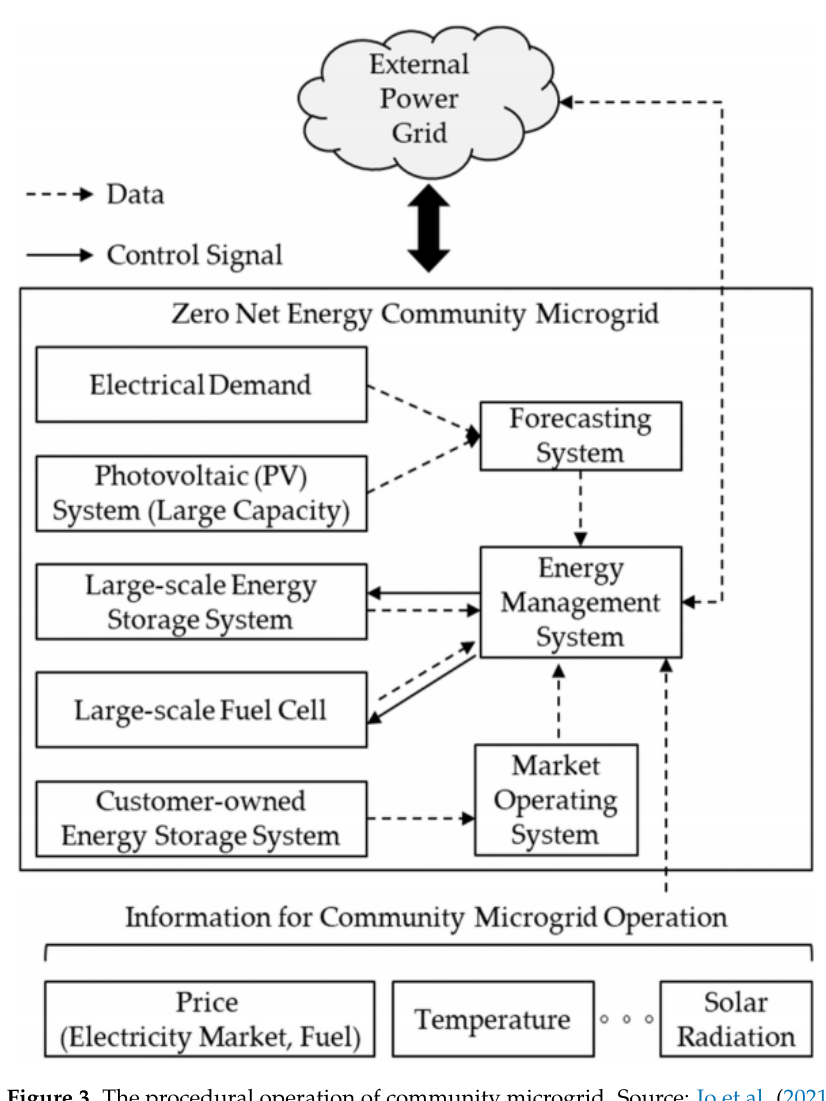
Figure 3. The procedural operation of community microgrid. Source: Jo et al. 2021.